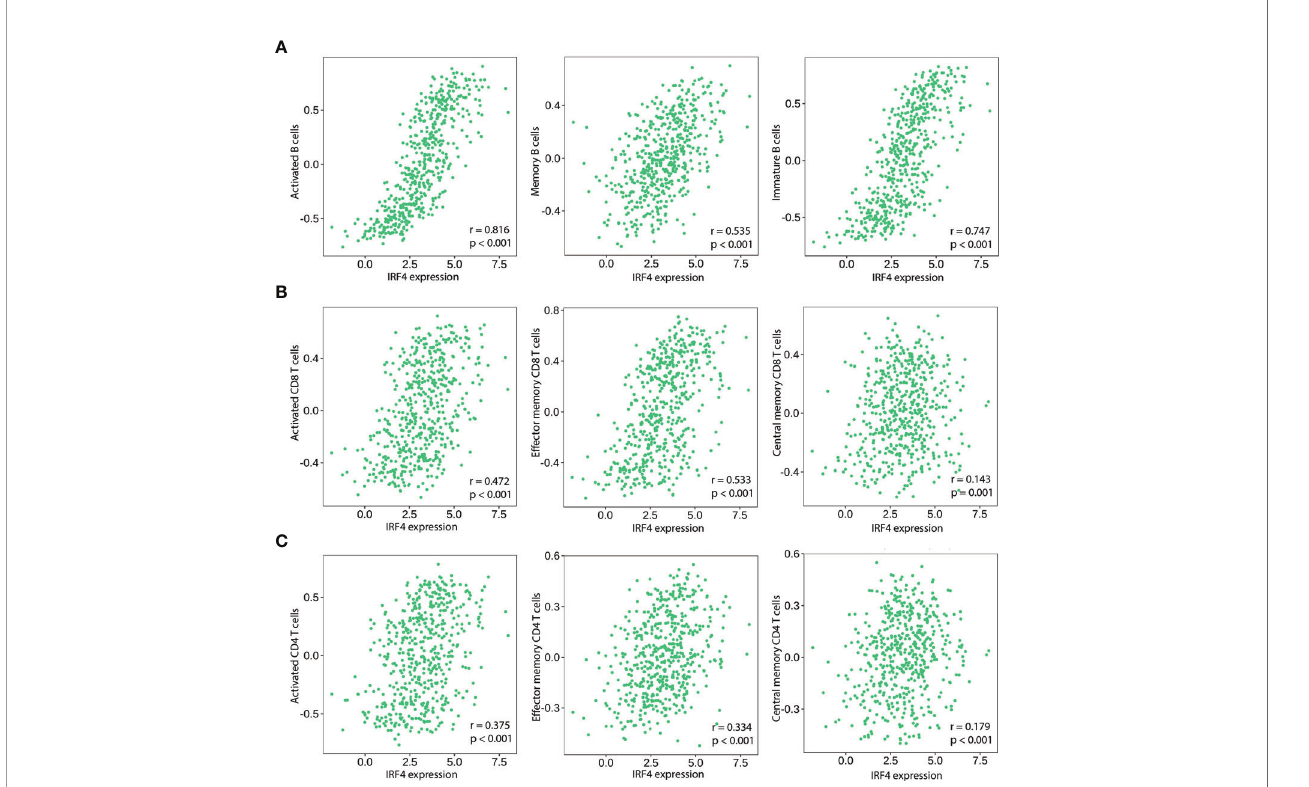
FIGURE 4 | Correlation of IRF4 expression with various B and T immune cell in fi ltration levels in LUAD by TISIDB database (n = 517). (A) IRF4 expression is signi fi cantly positively correlated with activated B Cells, memory B Cells and immature B Cells in LUAD. (B) IRF4 expression is signi fi cantly positively correlated with activated CD8+ T Cells, effective memory CD8+ T Cells and central memory CD8+ T Cells in LUAD. (C) IRF4 expression is signi fi cantly positively correlated with activated CD4+ T Cells, effective memory CD4+ T Cells and central memory CD4+ T Cells in LUAD. LUAD, Lung adenocarcinoma.